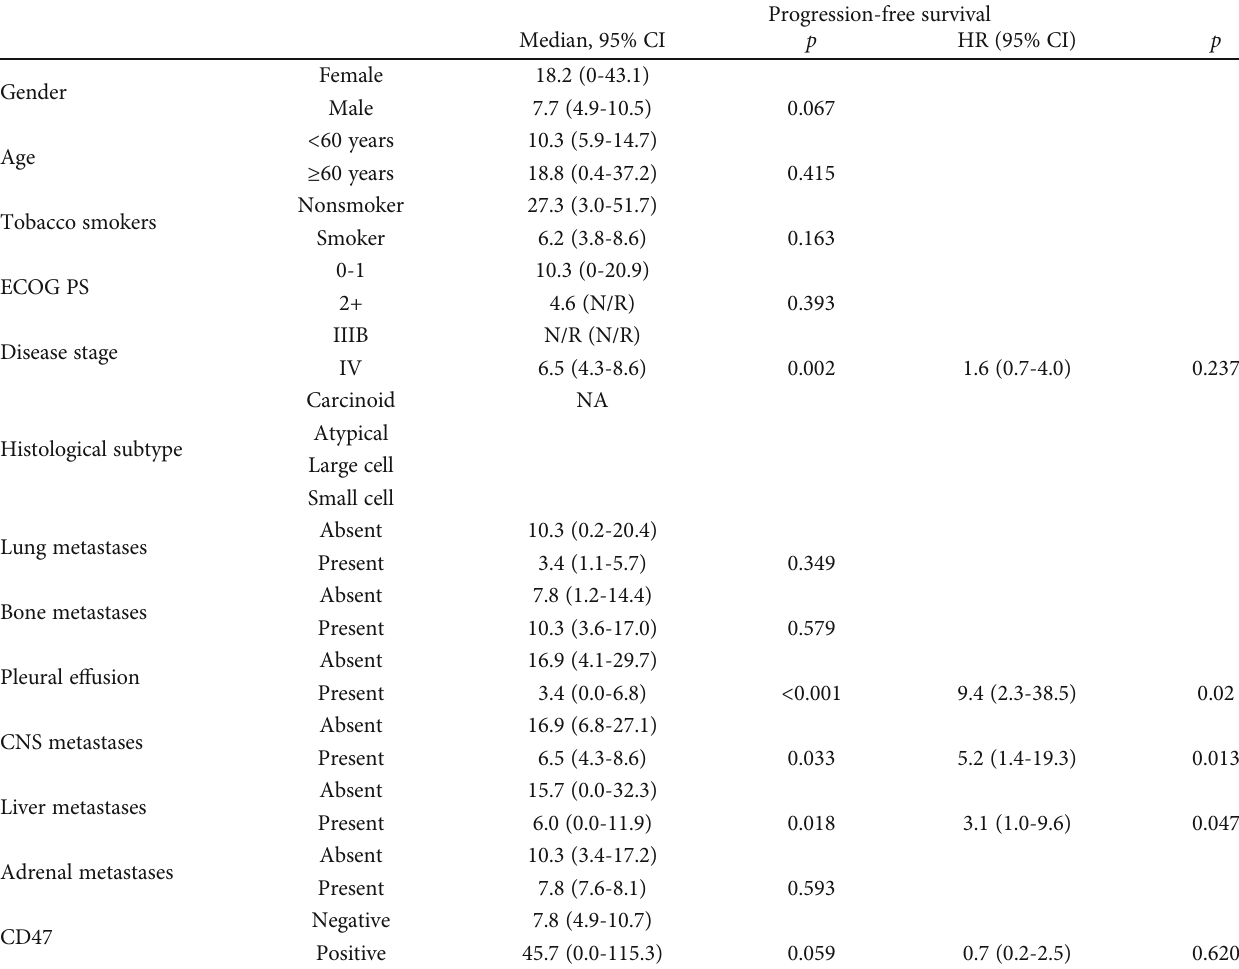
Table 2: Univariate and multivariate analysis for factors associated with